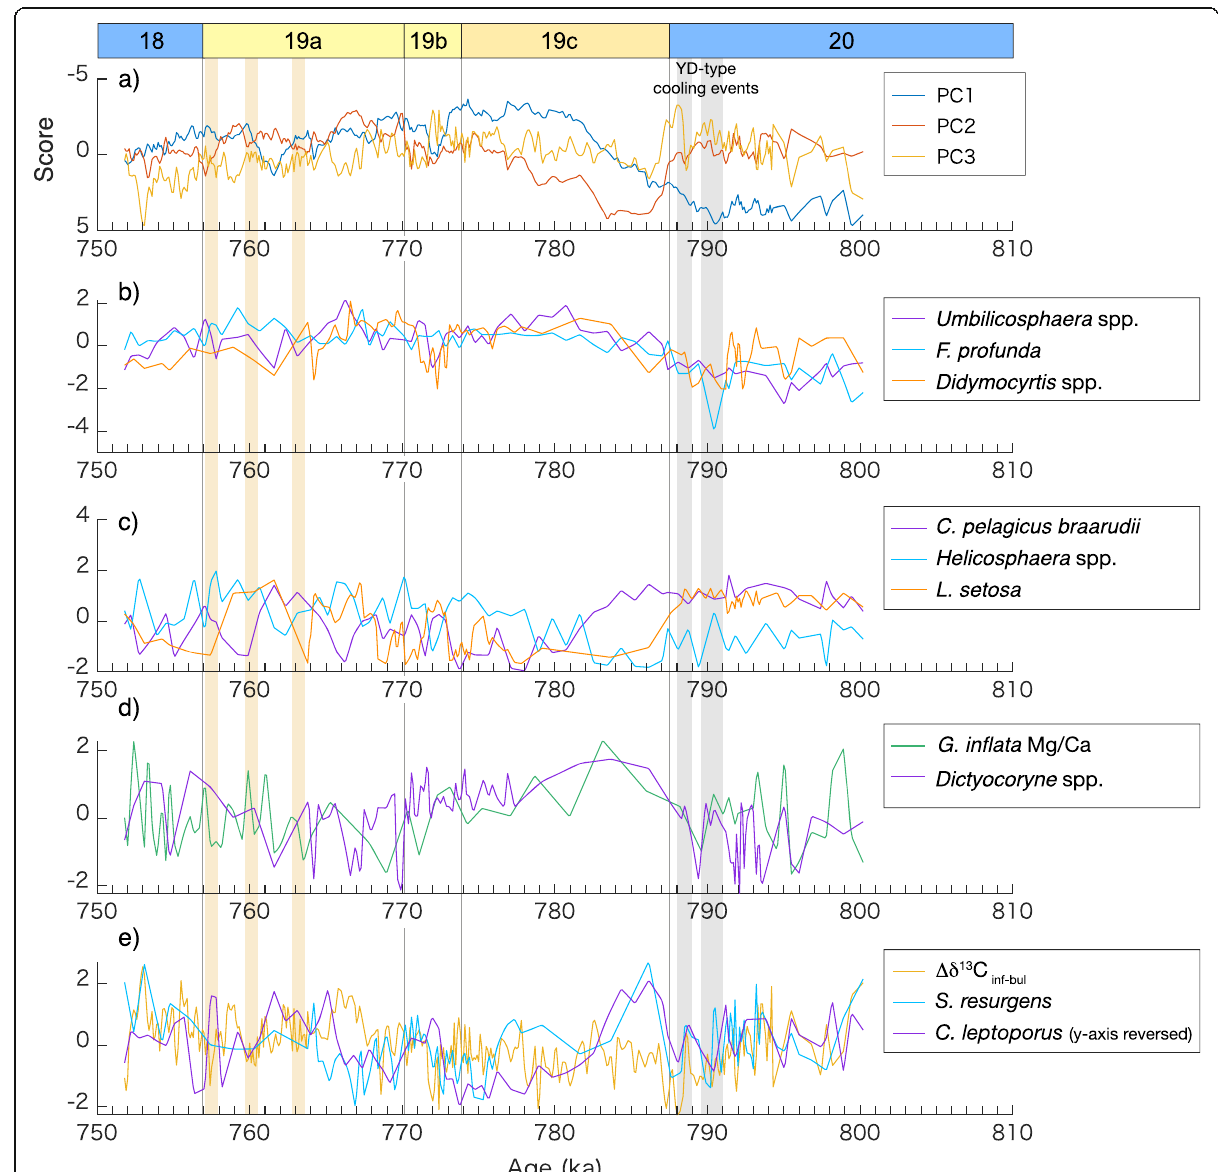
Fig. 4 Results of principal component analysis (PCA) compared to microfossil relative abundances and geochemical proxies. a Scores for PC1, PC2, and PC3. b , c Standardized microfossil relative abundances for PC1, d for PC2, and e for PC3, but the y axis for C . leptoporus is reversed. Highlighted events are the same as Fig.